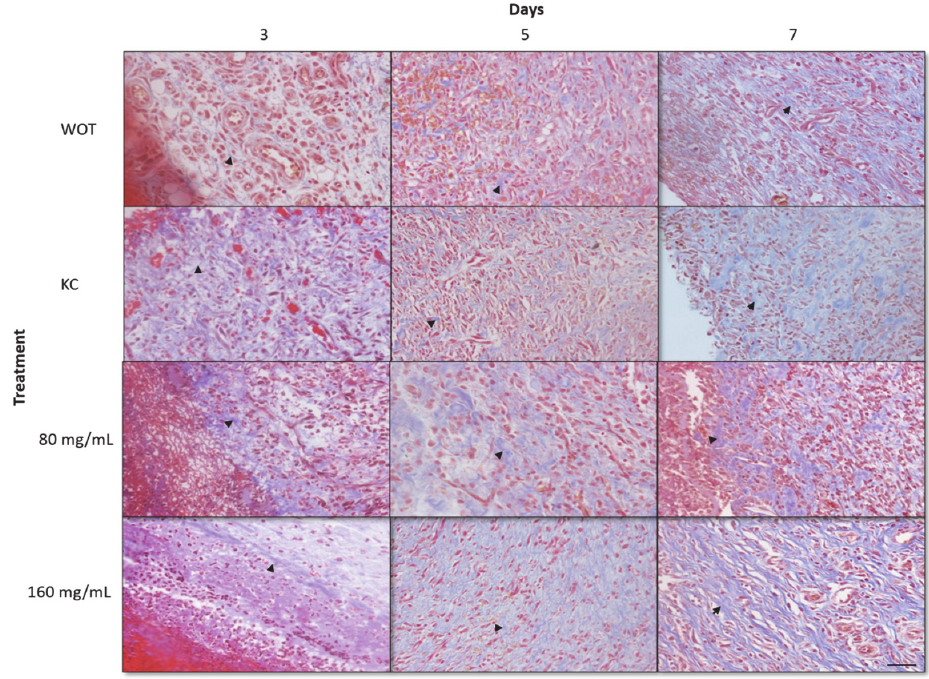
Figure 5. Masson’s trichrome staining of wounds. Representative microphotographs at 3, 5, and 7 days post ‐ wounding in WOT, KC, and 80 and 160 mg/mL of PB . Collagen fibers (black arrow). Bar = 20 μ m.